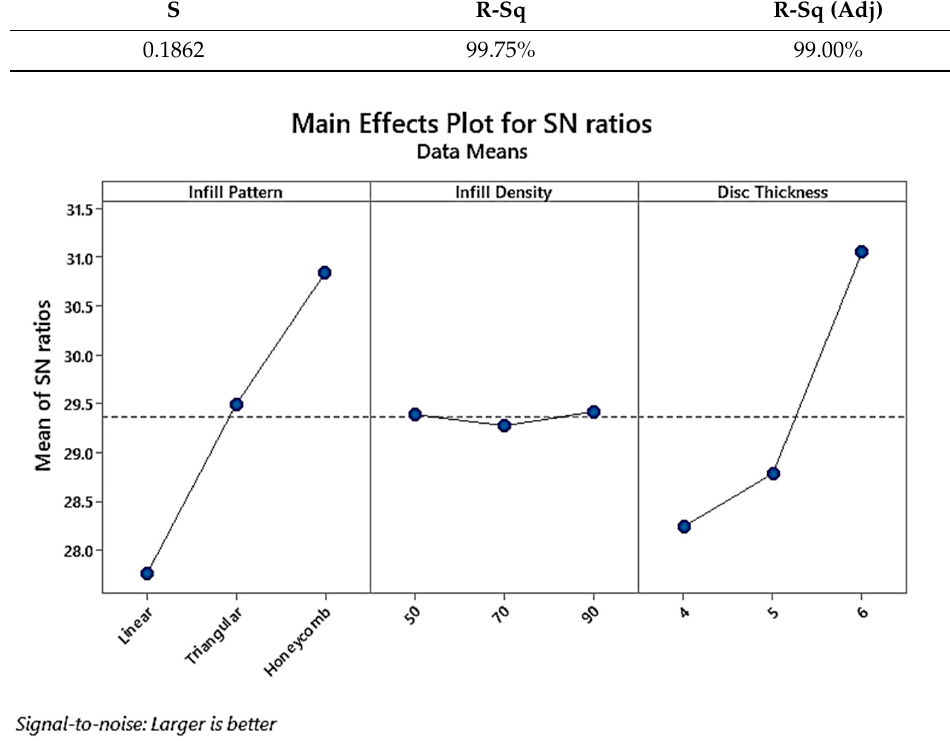
Table 8. Model Summary for the PLA samples.